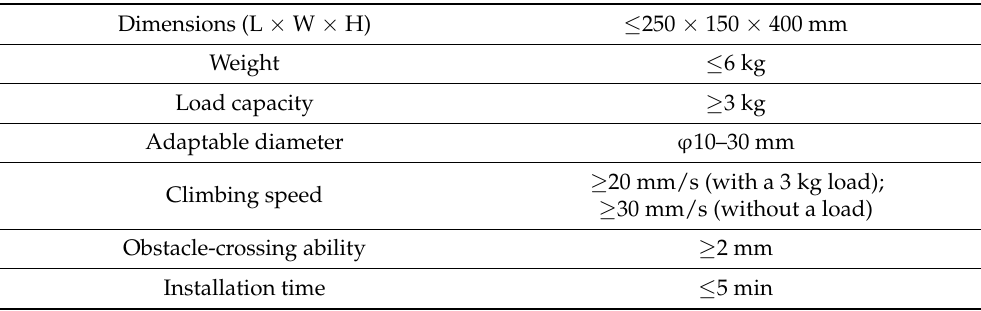
Table 1. Design requirements of the climbing robot for the sluice wire